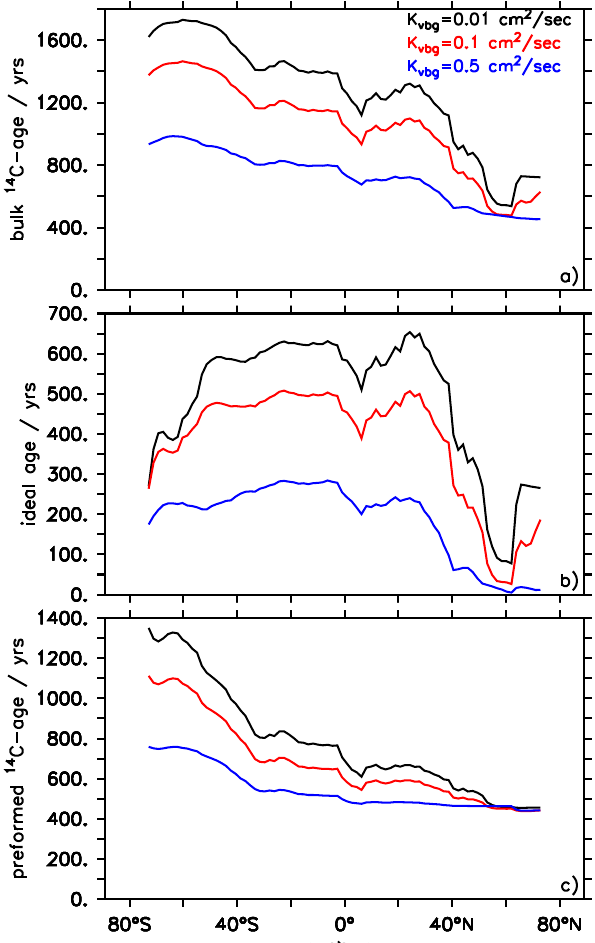
Figure 11. Sensitivity of Atlantic Ocean age patterns to vertical dif- fusivity ( K vbg ) in the UVIC model. (a) Bulk 14 C-age, (b) ideal age and (c) preformed 14 C-age. Preformed 14 C-age is diagnosed here from the difference of bulk age and ideal age.